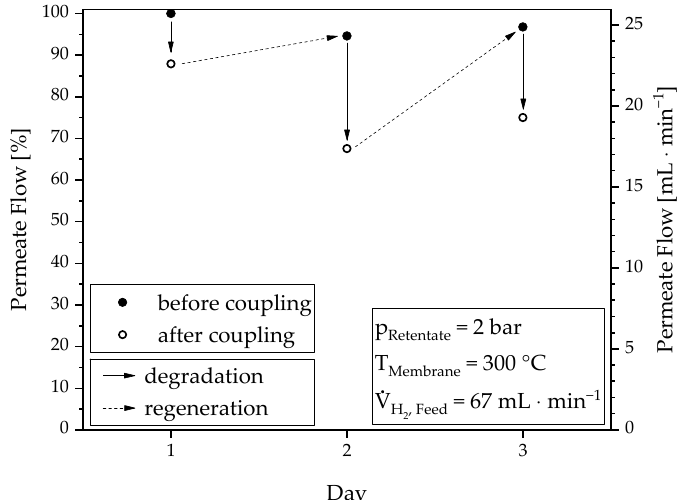
Figure 10. Degradation and regeneration behavior of the membrane: Hydrogen flow before and after each coupling experiment at constant conditions (2 bar, 300 °C and 67 NmL ∙ min − 1 ).